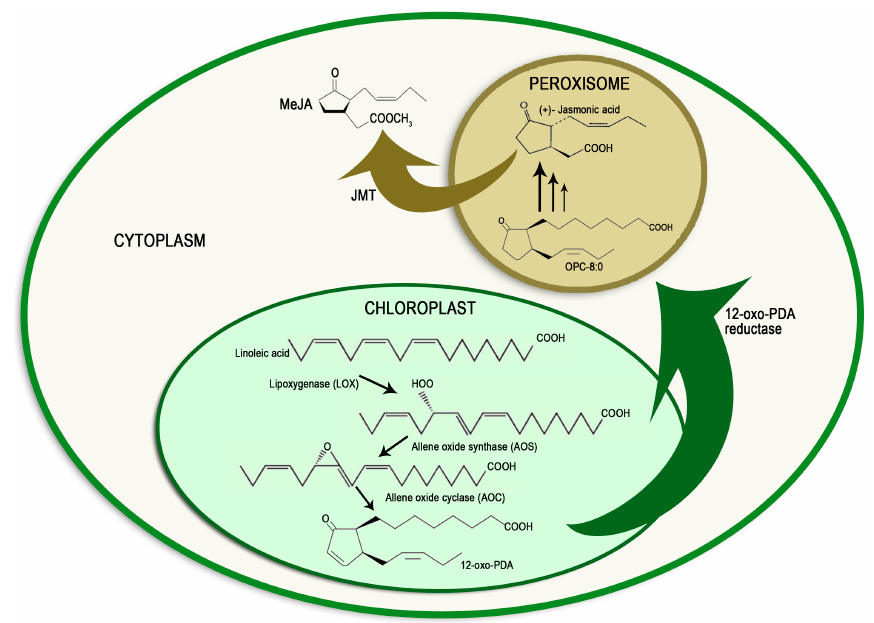
Figure 1. Methyl jasmonate biosynthesis involves chloroplast, cytoplasm and peroxisome. This synthesis scheme is based on studies of Arabidopsis thaliana plants. Abbreviations: AOC, allene oxide cyclase; AOS, allene oxide synthase; JMT, jasmonic acid methyl transferases, LOX,